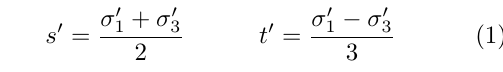
Figure 2. Critical friction angle ϕ played in Fig. 2. The effective stresses t 0 and s 0 in Fig. 2 are written